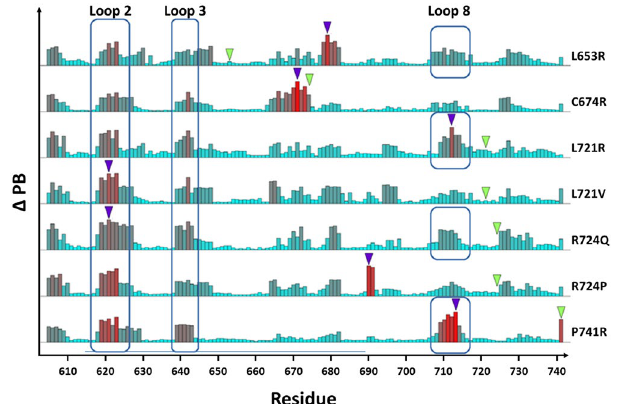
Figure 9. Comparative study of the Δ PB values for all WT-variant pairs. Histogram schema presenting the Δ PB value computed for each residue position (abscissa) from each variant and the WT systems. Green triangle indicates the aa variation position while the purple one position shows the position of maximal Δ PB. Residues from loops 2, 3 and 8 presenting common high Δ PB for all variants are